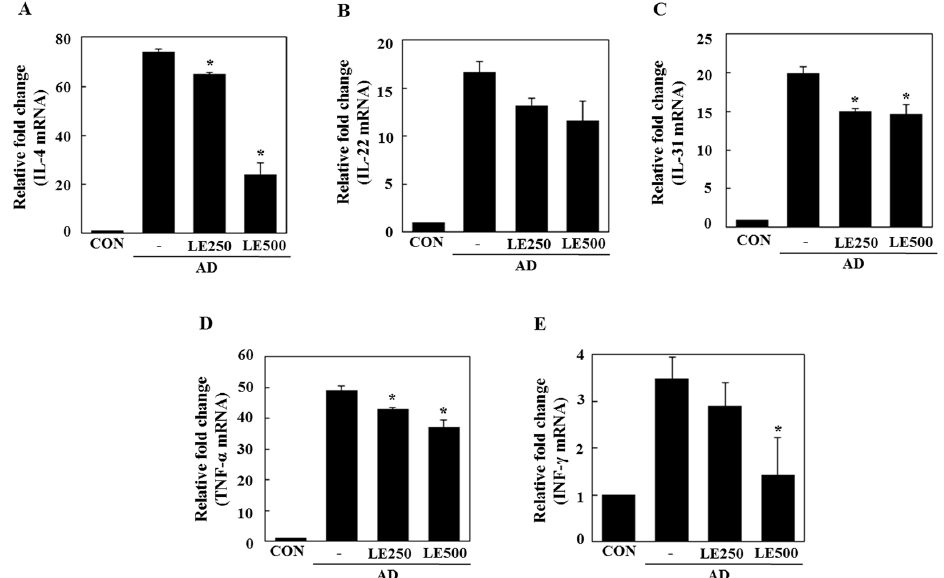
Figure 5. Effect L. edodes extract on the expression of various cytokines in the cervical lymph nodes. The cervical lymph node was excised on day 28 and total RNA was isolated. Quantitative real-time polymerase chain reaction was performed as described in the Materials and Methods. The relative fold change in mRNA for IL-4 ( A ); IL-22 ( B ); IL-31 ( C ); TNF- α ( D ); and INF- γ ( E ) are shown. Data are presented as the mean ± SD of triplicate determinations. * Significantly different from the value of the DFE/DNCB-treated mice at p < 0.05. DFE, Dermatophagoides farinae extract; DNCB, 2,4-dinitrochlorobenzene; AD, atopic dermatitis induced by DFE and DNCB treatment.